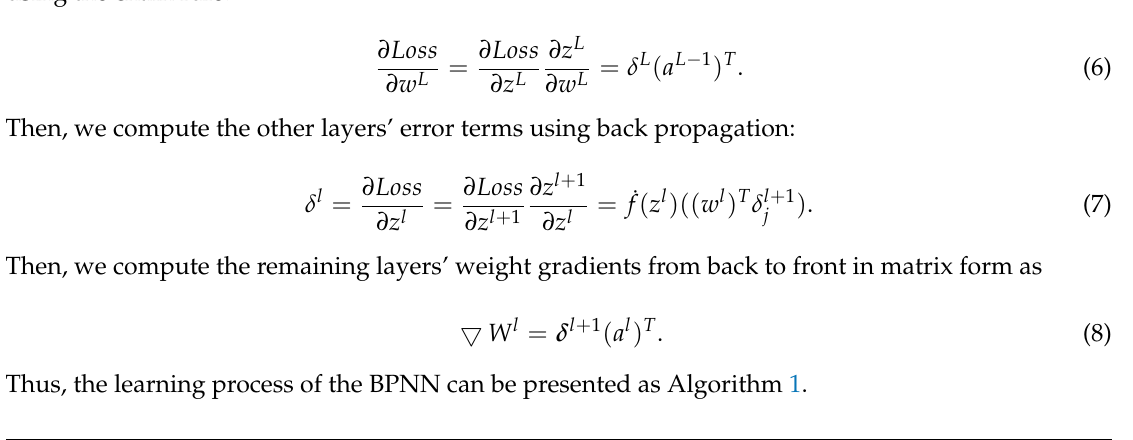
Algorithm 1: The BP network update process with gradient